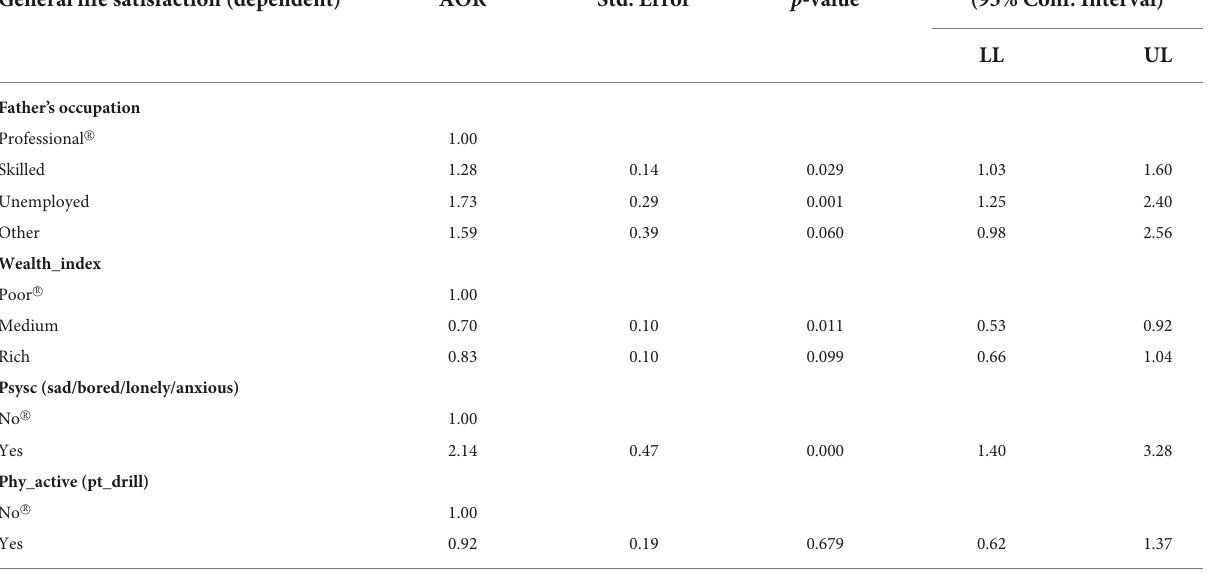
TABLE 3 Results of Logistic regression showing determinants of general life satisfaction among students during the pandemic. General life satisfaction (dependent) AOR Std. Error p -value (95% Conf.